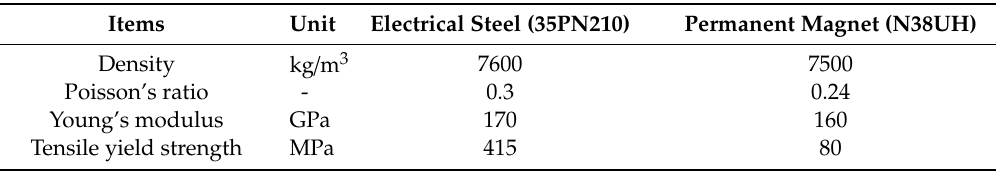
Table 4. Material properties for mechanical stress analysis.